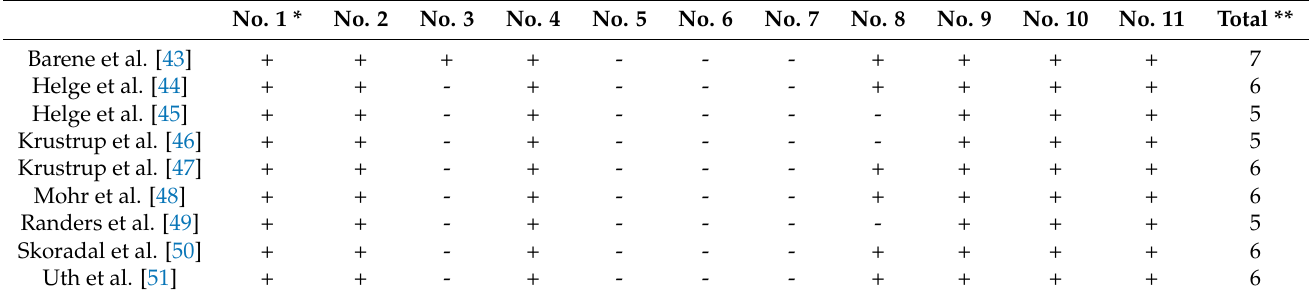
Table 5. Physiotherapy evidence database (PEDro) scale ratings.